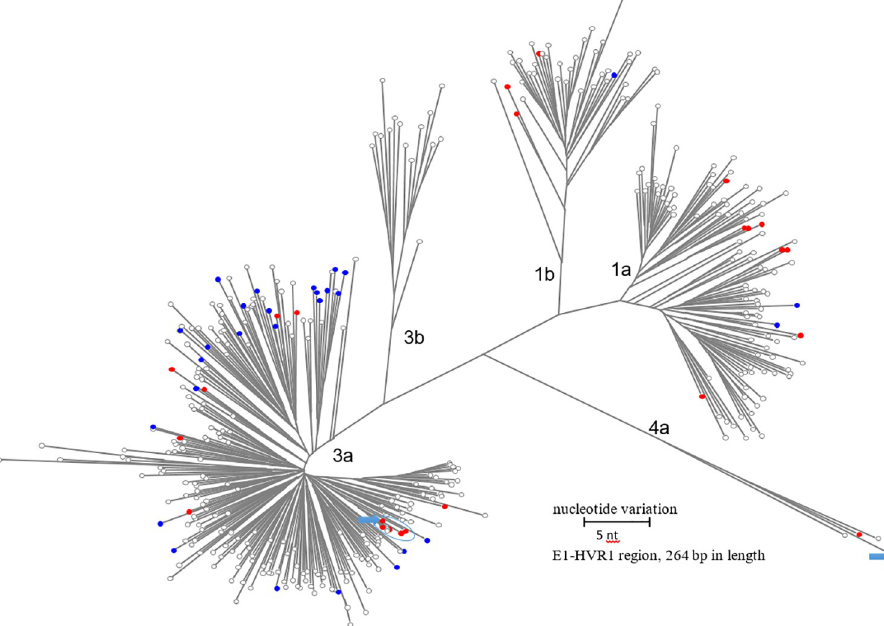
Fig 1. Unrooted maximum likelihood phylogenetic tree of HVR1 sequences 264 bp of length (NGS major haplotypes only) identified in this study (red) and shown in the context of GenBank reference sequences (grey) and other HVR1 sequences from Pakistan (blue). Clustered sequences are encircled. Arrows indicate HVR1 sequences of genotype 3a and 4a derived from PK-3 (mixed genotype infection).